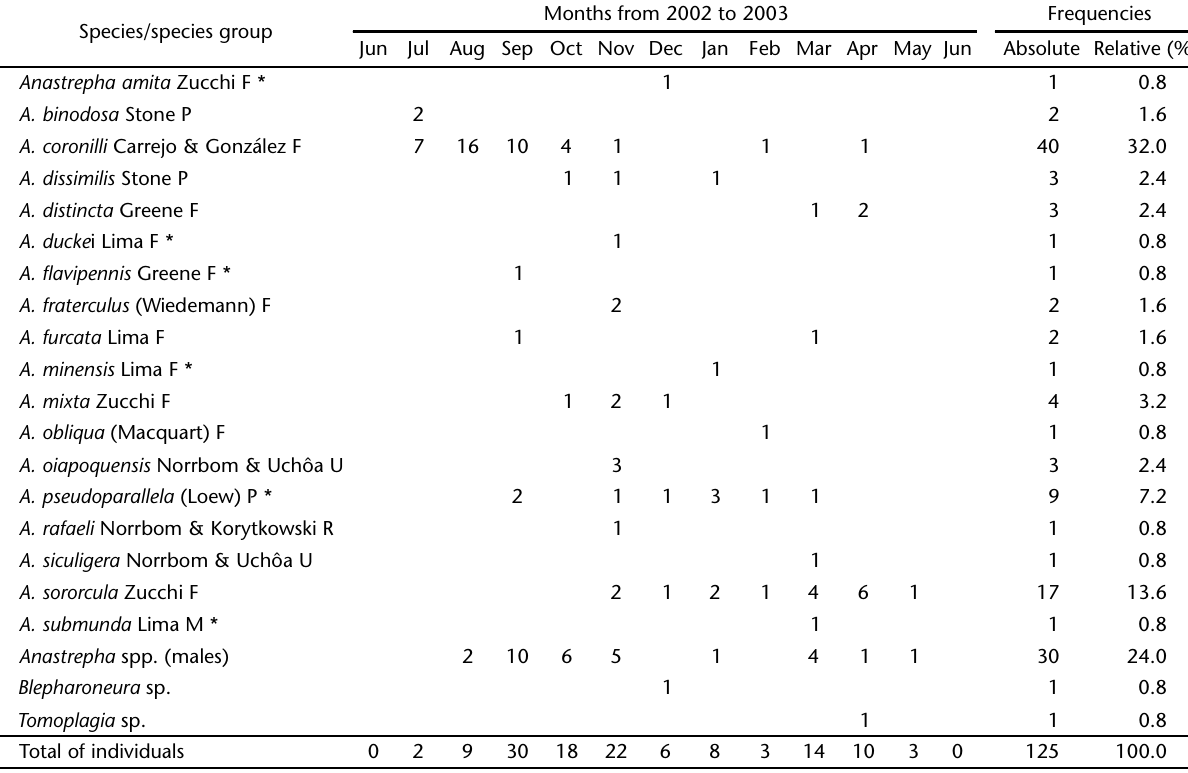
Table I. Species of Tephritidae from Clevelândia do Norte, municipality of Oiapoque, Amapá: monthly capture, abundance, and frequencies (absolute and relative) (June 2002 to June 2003). Months from 2002 to 2003 Frequencies Species/species group Jun Jul Aug Sep Oct Nov Dec Jan Feb Mar Apr May Jun Absolute Relative